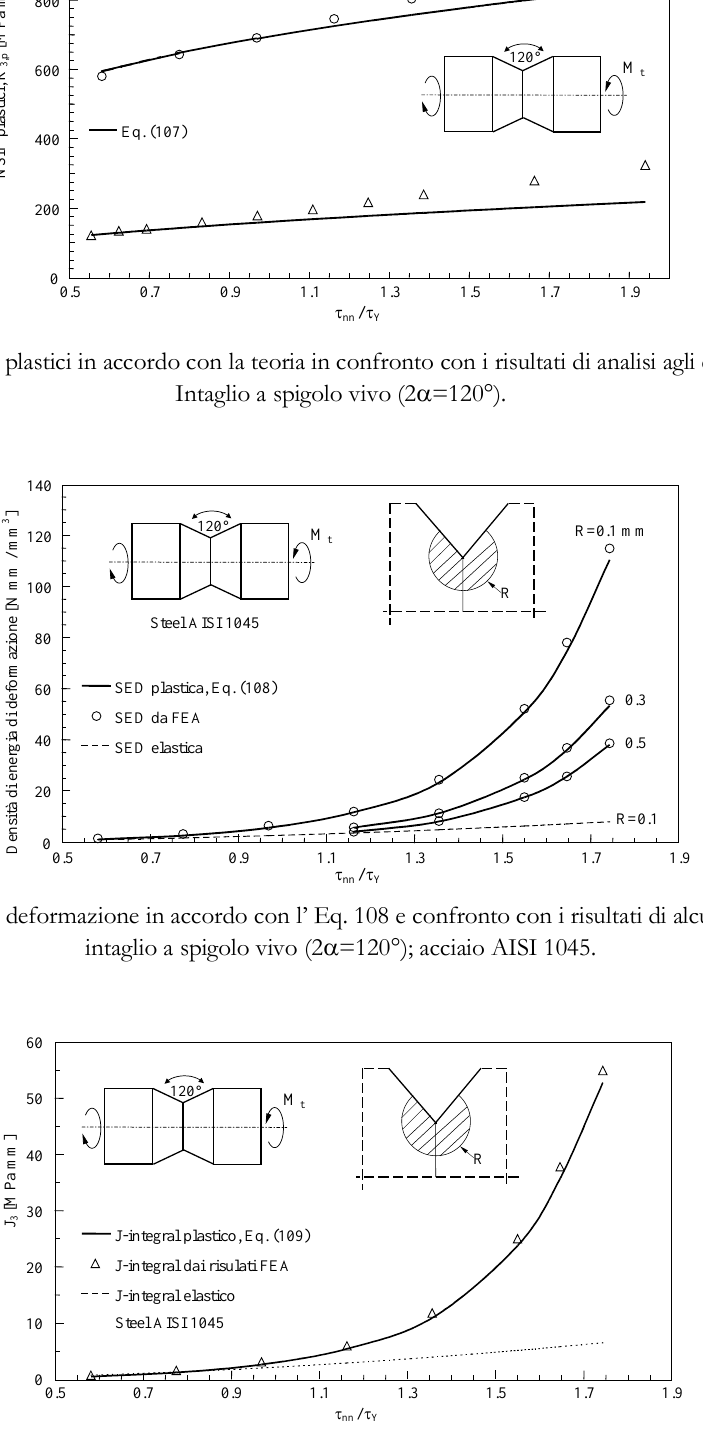
Figura 18: J-integral in accordo con l’Eq.109 e confronto con i risultati di alcune analisi agli elementi